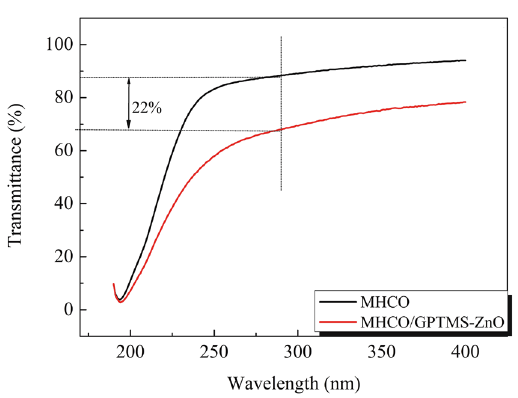
Figure 8. UV transmittance spectra of MHCO/GPTMS-ZnO composites and